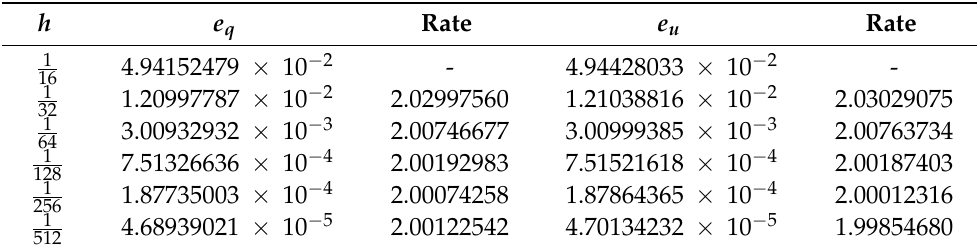
Table 3. Error e q and e u for the spatial convergence rates with α = 0.7.